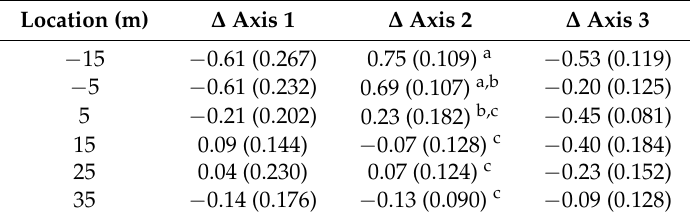
Table A3. Means with standard error in parentheses for differences in Axis scores between observed plots at each location relative to harvest edge and reference plots (45 m into harvest). Negative numbers for distance from edge indicate plots are unharvested (Figure 1). Lower-case letters in superscript indicate significant differences ( p < 0.05) between plot means at different distances where distance as determined with post-hoc Tukey-adjusted pairwise comparisons was a significant main factor.